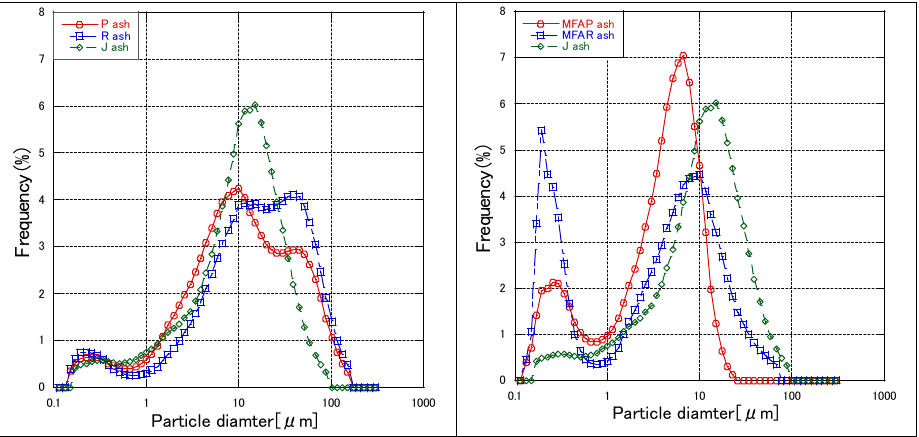
Figure 5. The particle size distribution of fly ash. Figure 6 has two parts. One part is the activity indices of different unmodified fly ashes. As shown in the figure, the activities of the three different fly ashes vary greatly. The activity indices of PFA and RFA change with the increase of time. However, PFA con- forms to the JIS II fly ash standard at 28 and 91 days before modification.